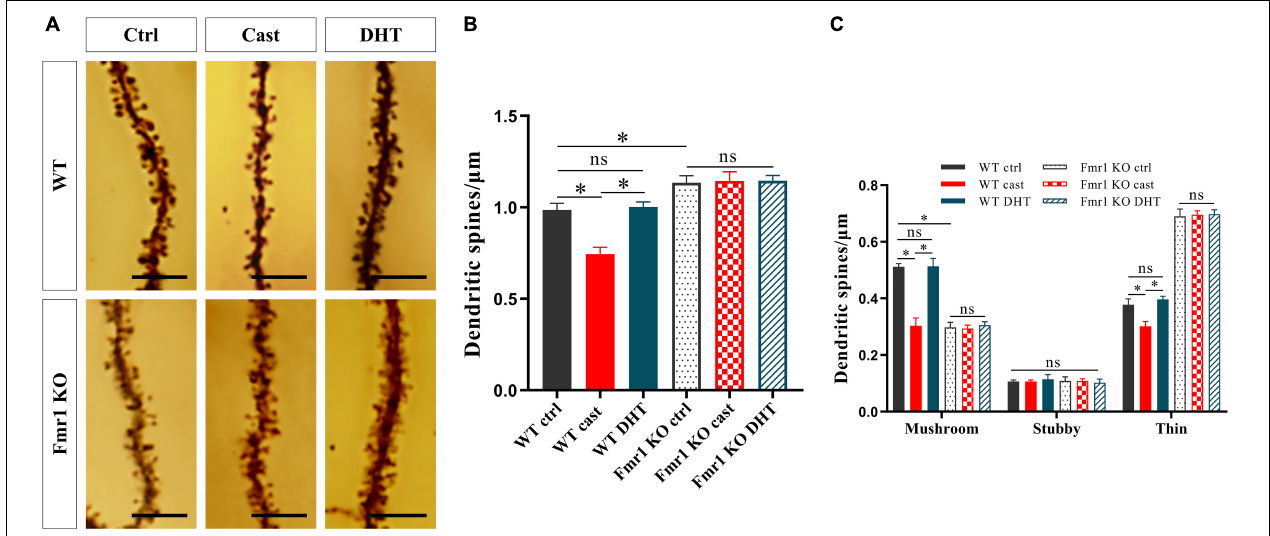
FIGURE 6 | Effects of castration and DHT supplementation on dendritic spines of Fmr1 KO mice. (A) Golgi staining of hippocampal CA1 pyramidal neurons for dendritic spine counting after behaviors. Scale bars = 5 µ m. (B) Quantification of dendritic spine density in hippocampal CA1 pyramidal neurons calculated as the number of spines per 1 µ m of dendrite. (C) Quantification of mushroom, stubby, and thin dendritic spine density in hippocampal CA1 pyramidal neurons calculated as the number of spines per 1 µ m of the dendrite (* p < 0.05, n =